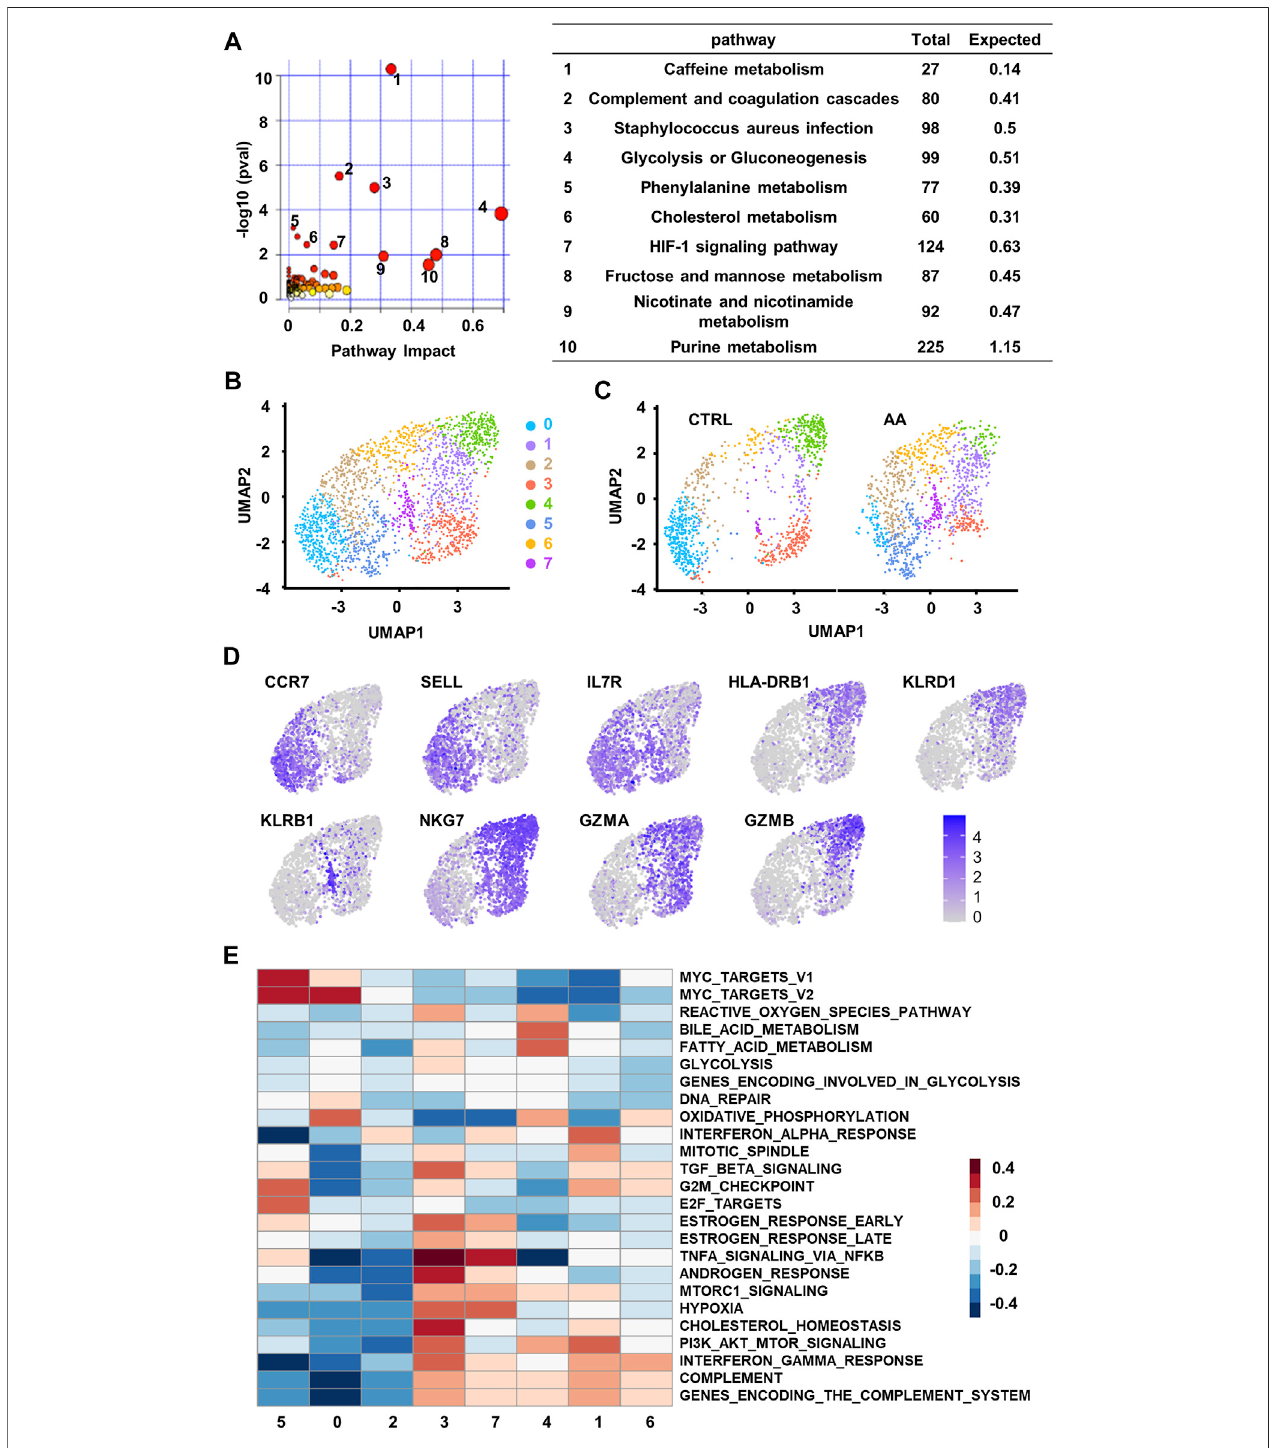
FIGURE3 | Single-celltranscriptional analysisrevealsclustersofCD8 + Tcells associatedwithplasma changesin AApatients. (A) Integratedjoin pathway analysis showing top 10 pathways of upregulated proteins and metabolites in SAA patients. (B) UMAP visualization of CD8 + T-cell clusters based on single-cell transcriptomes. Each dot represents a single cell; circles with different colors and numbered labels indicate cell clusters. (C) UMAP visualization of CD8 + T-cell clusters from healthy control (CTRL) and AA patients. (D) Feature plot showing marker gene expression in each cluster. (E) GSVA heatmap showing hallmark pathways enriched in different clusters. AA, aplastic anemia; SAA, severe aplastic anemia; UMAP, Uniform Manifold Approximation and Projection; GSVA, gene set variation analysis.